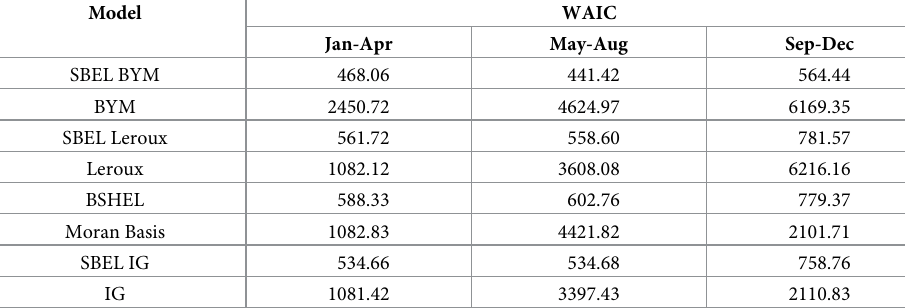
Table 5. Model performance (WAIC) for COVID-19 data models in three periods of 2020.